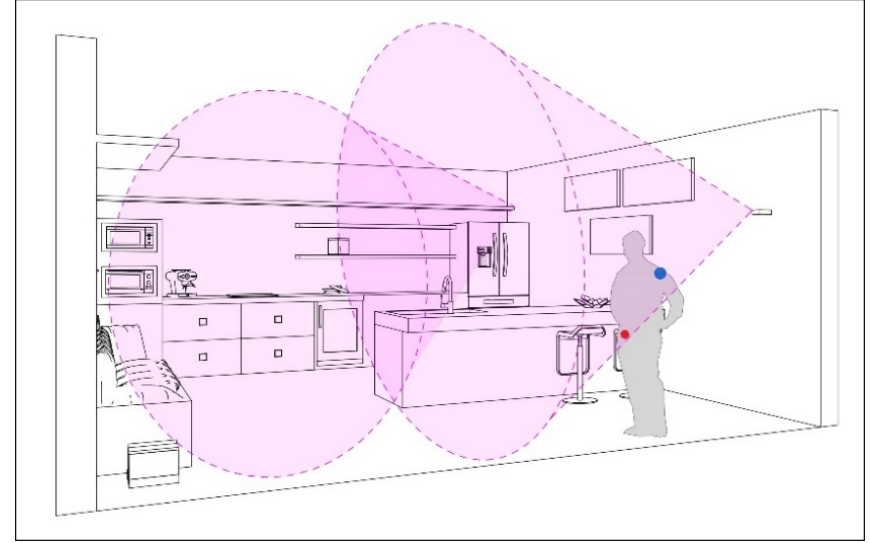
Figure 4. Possible solution for the installation of two cooperative readers in a typical indoor scenario.